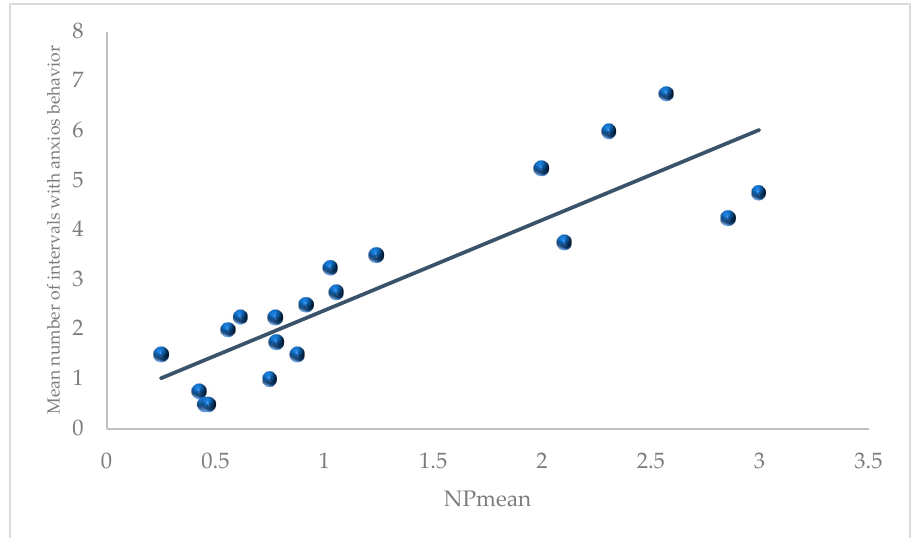
Figure 3. Correlation between mean scores for NP for each pair and the mean scores for anxious behavior averaged across the protected and continuous full contact stages.